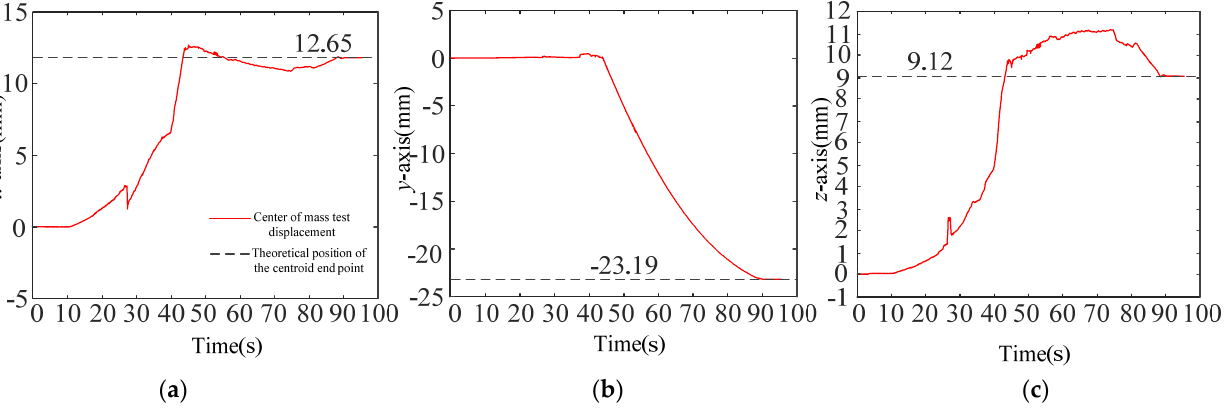
Figure 30. The displacement of the center of mass of the captured test payload in the third boundary pose (see Table 5 for details). ( a ) The x -axis displacement of the center of mass of the captured test payload in the third boundary pose; ( b ) The y -axis displacement of the center of mass of the captured